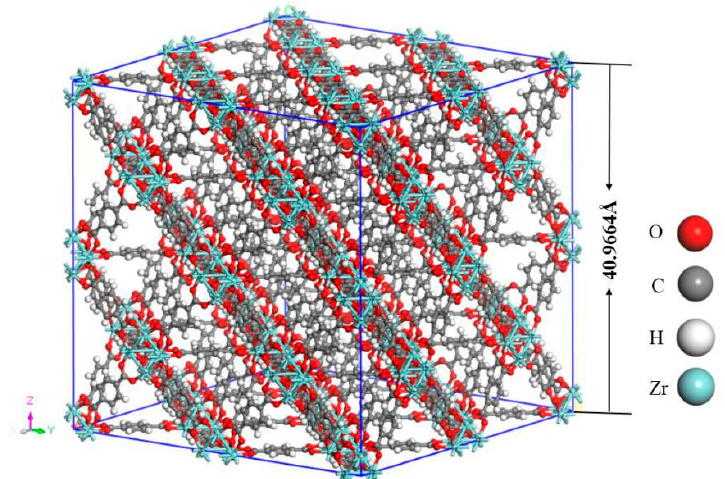
Figure 1. The 4 × 4 × 4 unit cells of UIO-6.